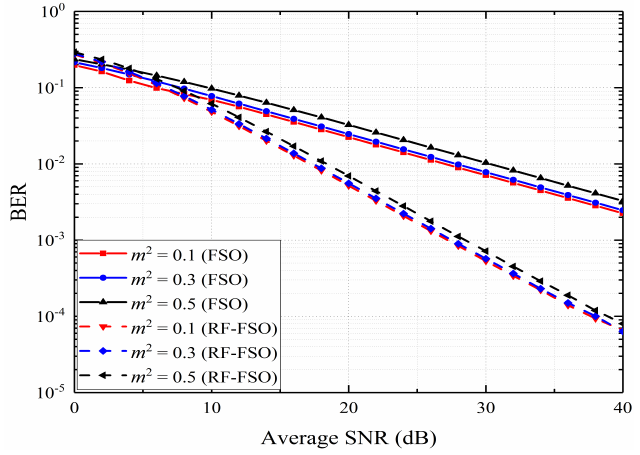
Figure 7. Average BER of 16-PPM–BPSK–SIM RF/FSO system and the FSO system against the average SNR under various scintillation indices and the pointing error parameter ξ =